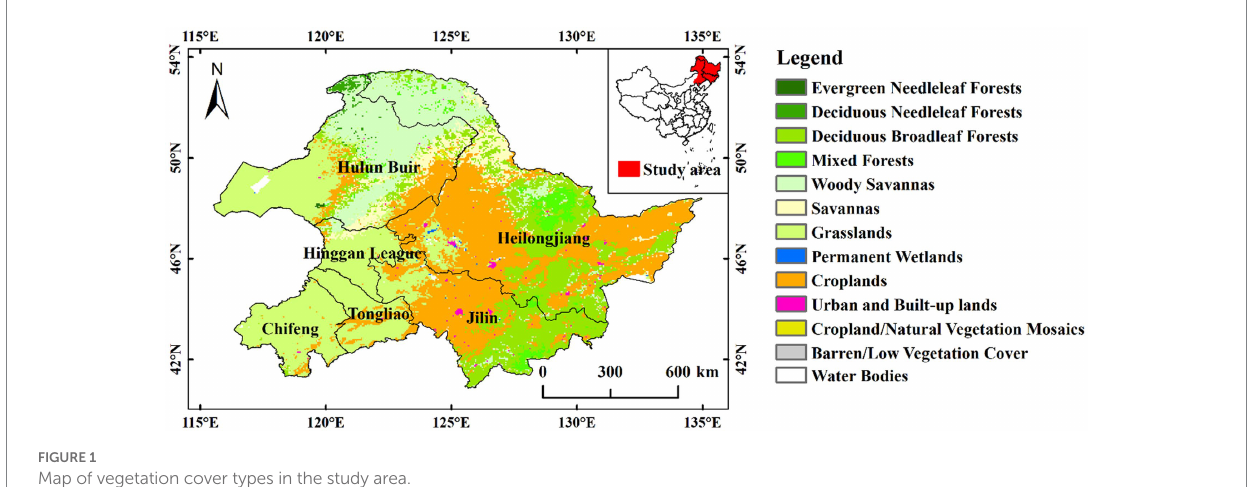
FIGURE 1 Map of vegetation cover types in the study